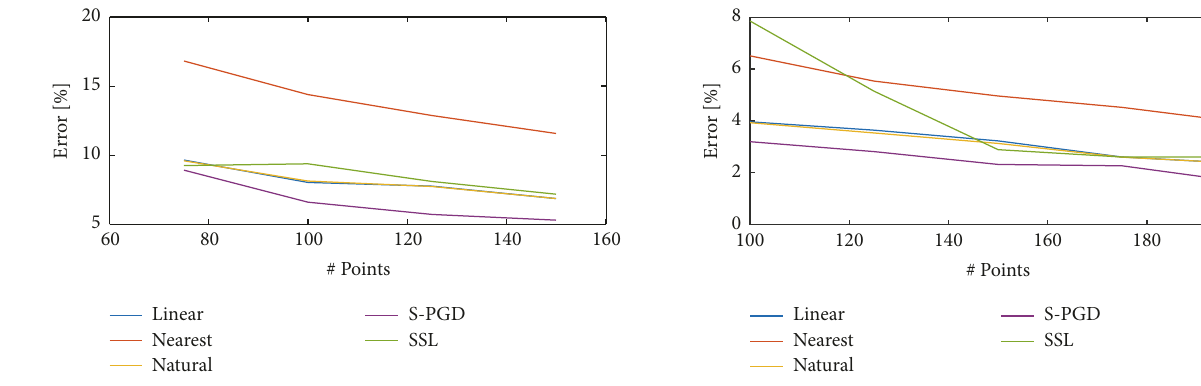
Figure 9: E L of 𝑅(𝜃,𝜎 𝑥𝑦 ) varying # P for different sparse identifi- cation techniques. # L = 1000 . 𝜖 𝑟 = 5 ⋅ 10 −4 .